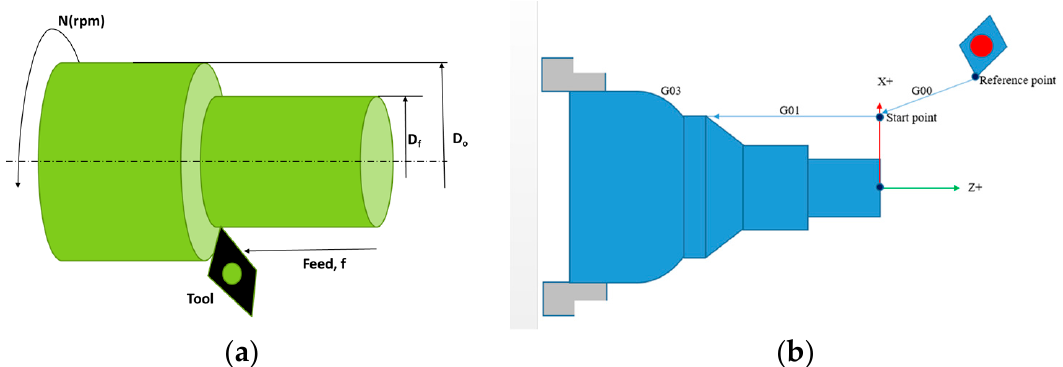
Figure 10. Schematic diagram of turning parameters and demonstration. ( a ) Geometric description and parameter definitions for turning operation, ( b ) Axis assignment convention and demonstration of motion types.